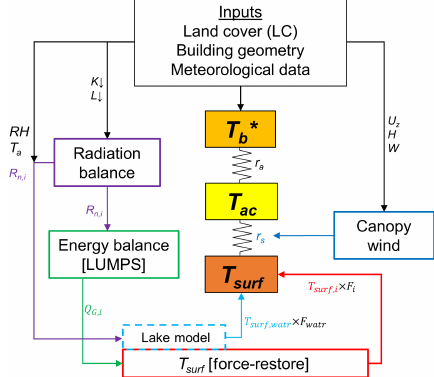
Figure 1. Schematic of TARGET urban canyon set-up. T ac is the canopy layer air temperature, and T b is the above-canopy air tem- perature, which is a uniform value across the whole domain. W roof is the roof width, W tree is the tree width, W is canyon width, and W ∗ = W − W tree . The surface beneath trees is assumed to be repre- sentative of canyon ground-level surfaces.